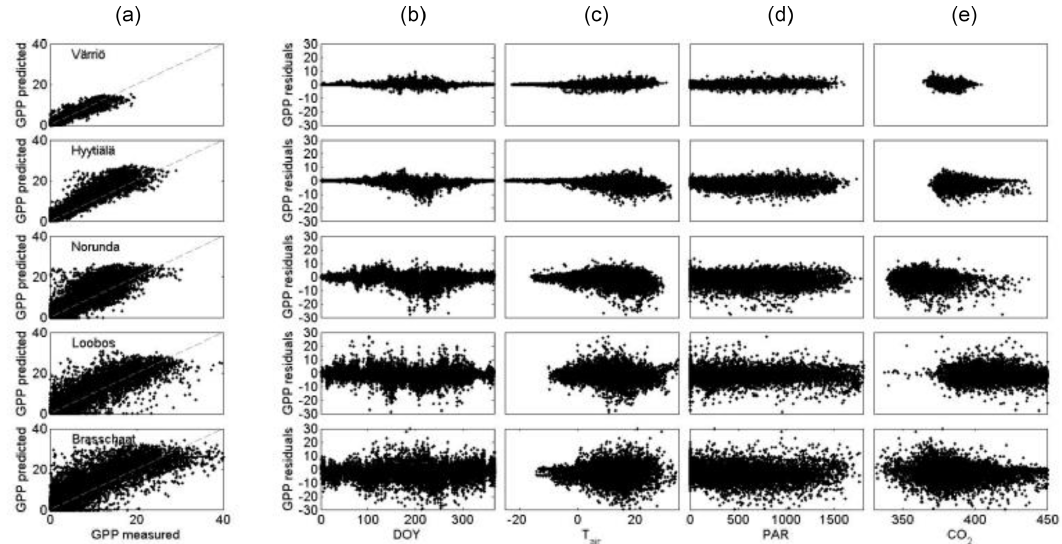
Figure 4. The relationship between measured and predicted gross primary production (a) . (b) – (e) present the residuals as a function of time, air temperature, photosynthetically active radiation (PAR) and carbon dioxide